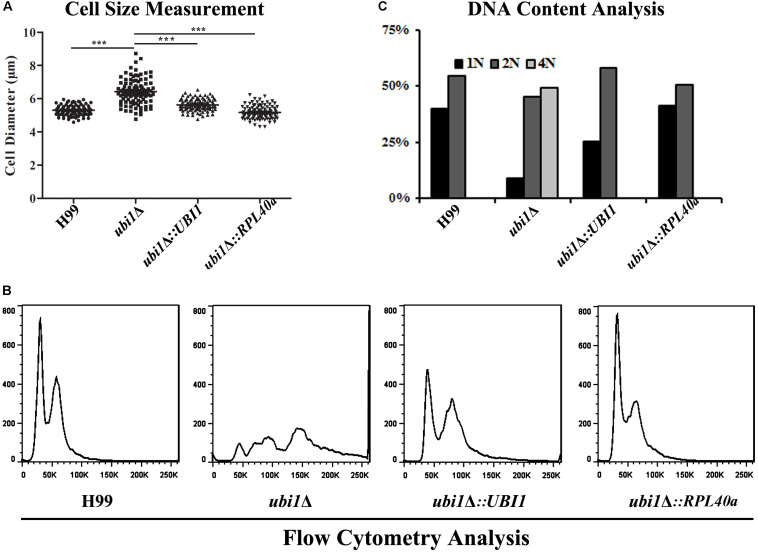
The C-terminal domain Rpl40e is responsible for the function of Ubi1 in regulating cryptococcal growth. (A) Deletion of Ubi1 led to enlargement of cell size in C. neoformans. Each strain was incubated to mid-log phase at 30°C, washed, and then visualized using the 63× objective of a Zeiss LSM inverted confocal microscope (Jena, Germany). ***P < 0.001. For each culture, the cell sizes of at least 100 cells were measured by using Adobe Photoshop Software. Flow cytometry analysis was performed to assess the effect of UBI1 deletion on the ploidy (B) and cell cycle progression (C) of C. neoformans. Each experiment was performed in duplicate.